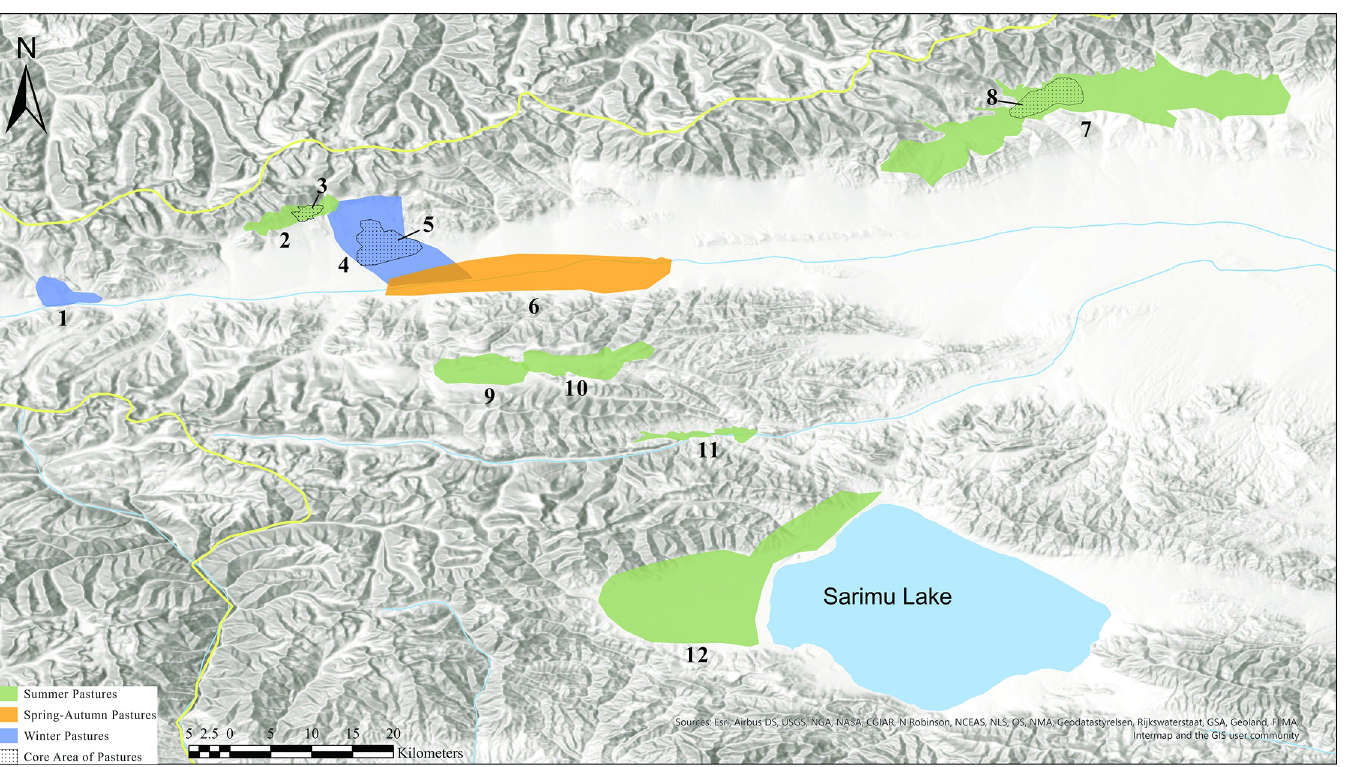
Fig 10. Location and area of seasonal pastureland in Wenquan: 1. Kazan Winter pasture 2, Adunqiaolu northwest summer pasture, 3. Adunqiaolu northwest core area of summer pasture, 4. Adunqiaolu winter pasture, 5. Core area Adunqiaolu winter pasture, 6. Wenquan spring-autumn pasture, 7. Entire Husta Grassland -summer-spring– autumn, 8. The Centre of Husta-summer-spring-autumn, 9. Harnur summer 1, 10. Harnur summer pasture 2, 11. Xiaowenquan Summer pasture, 12. Sarimu Lake summer pasture. Image created using ArcGIS Pro 2.5.0. Single use licence issued to Meng Qi by ESRI Australia Pty Ltd (Environmental Systems Research Institute). We acknowledge the use of Esri base maps as noted in the